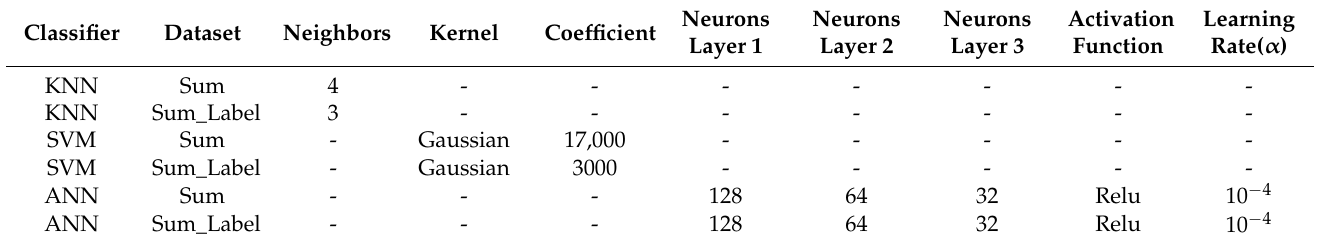
Table 4. The optimal configurations of k-NN, SVM and ANN classifiers for adding a sex labeling obtained from the training